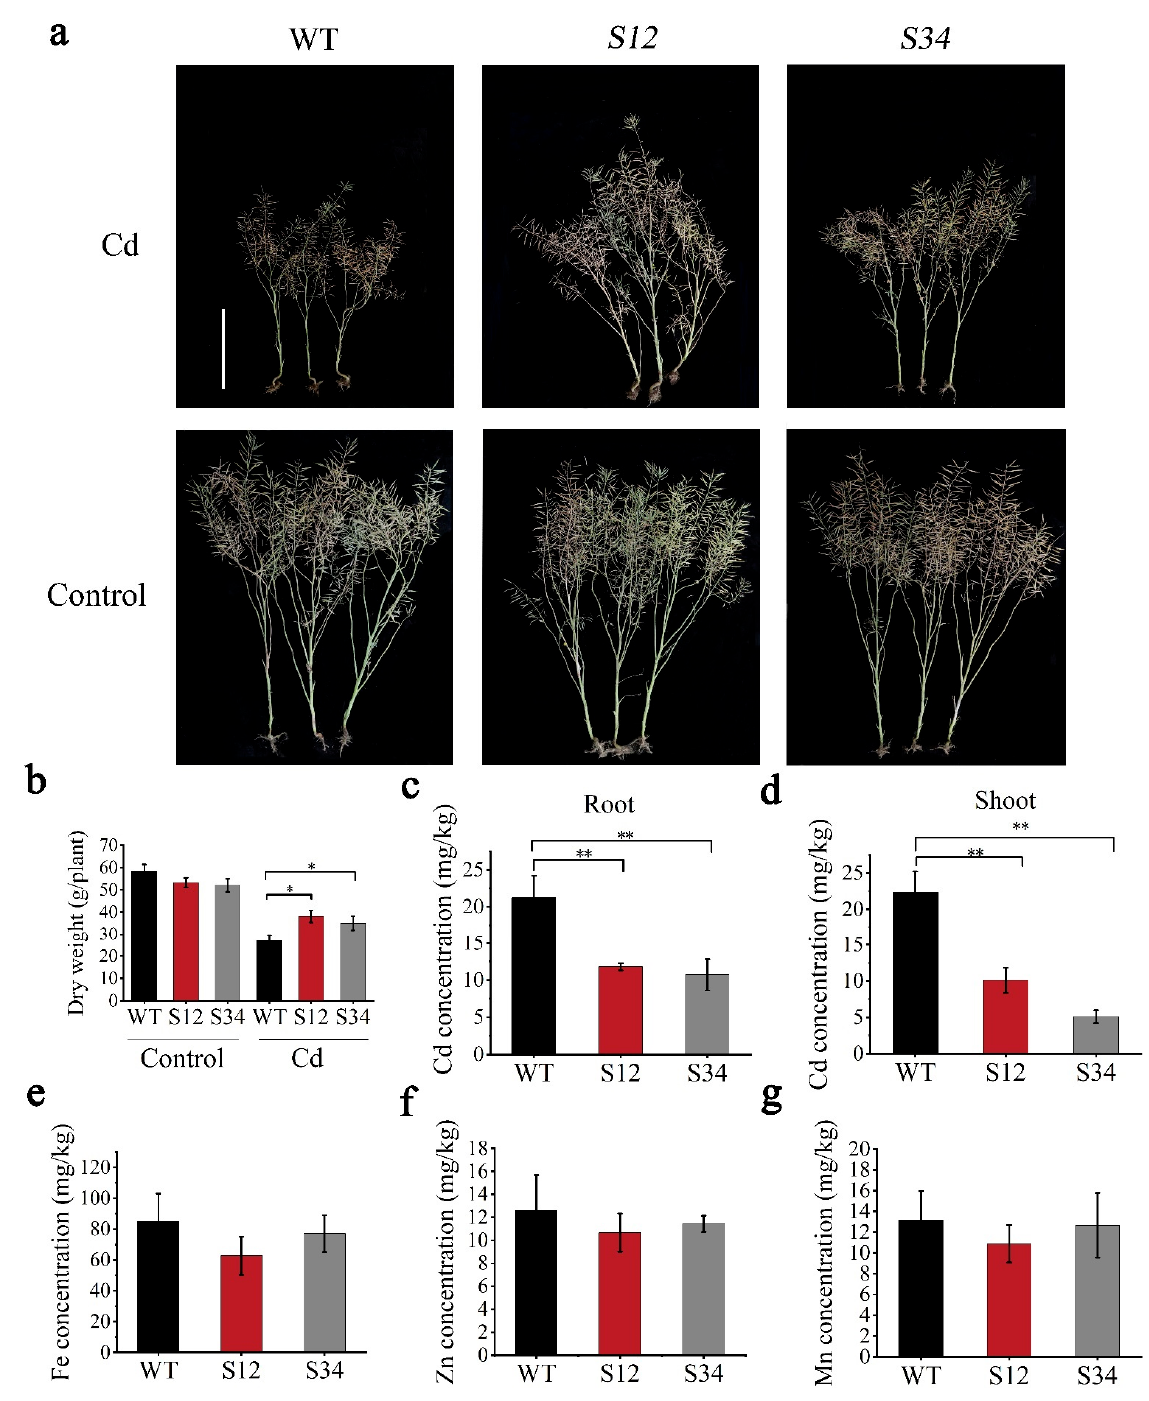
Figure 6. The field experiment for CRISPR-BnCUP1 lines. ( a ) Growth status of three lines (WT, S12 and S34 ) planted in Cd-contaminated fields and control fields. Bars indicate 50 cm. ( b ) Dry weight of seven-month-old WT, S12 and S34 oilseed rape grown in Cd-contaminated fields and control fields. ( c , d ) Cd concentration in roots and shoots of WT, S12 and S34 oilseed rape, respectively. ( e , f , g ) Concentrations of Fe, Zn and Mn in WT, S12 and S34 oilseed rape grown in Cd-contaminated fields. All data were obtained from independent triplicate experiments and the error bar represents standard deviation. Statistical analysis was performed by Student’s t- test (* p < 0.05, ** p <